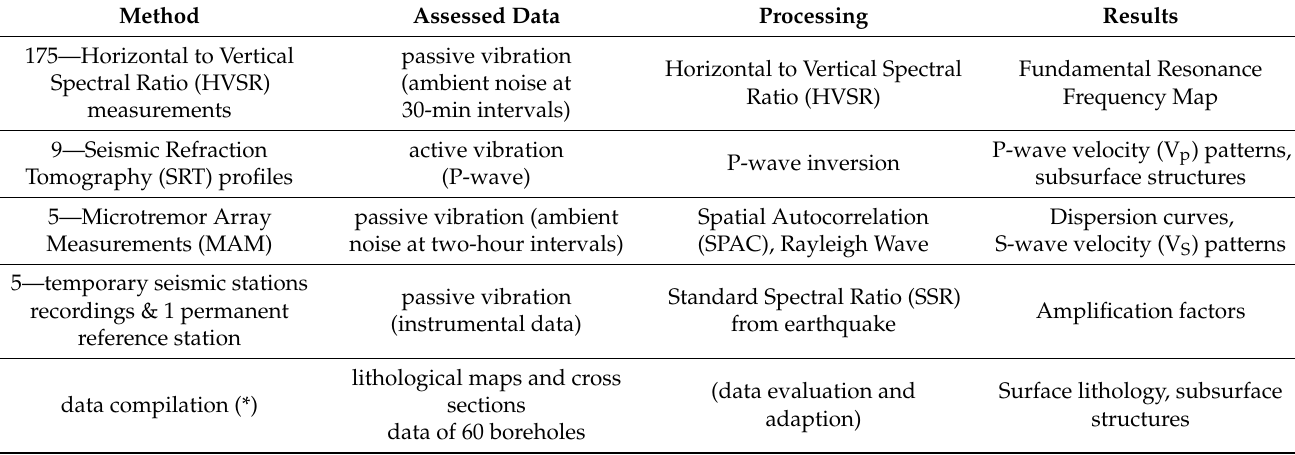
Table 1. Non-invasive methods used for the collection of new data. Compiled data (*) from the Head Institute of Engineering and Technical Surveys of the State Construction Committee of Tajikistan (HIETSCCT; 2019) were evaluated and adapted to meet the requirements of our